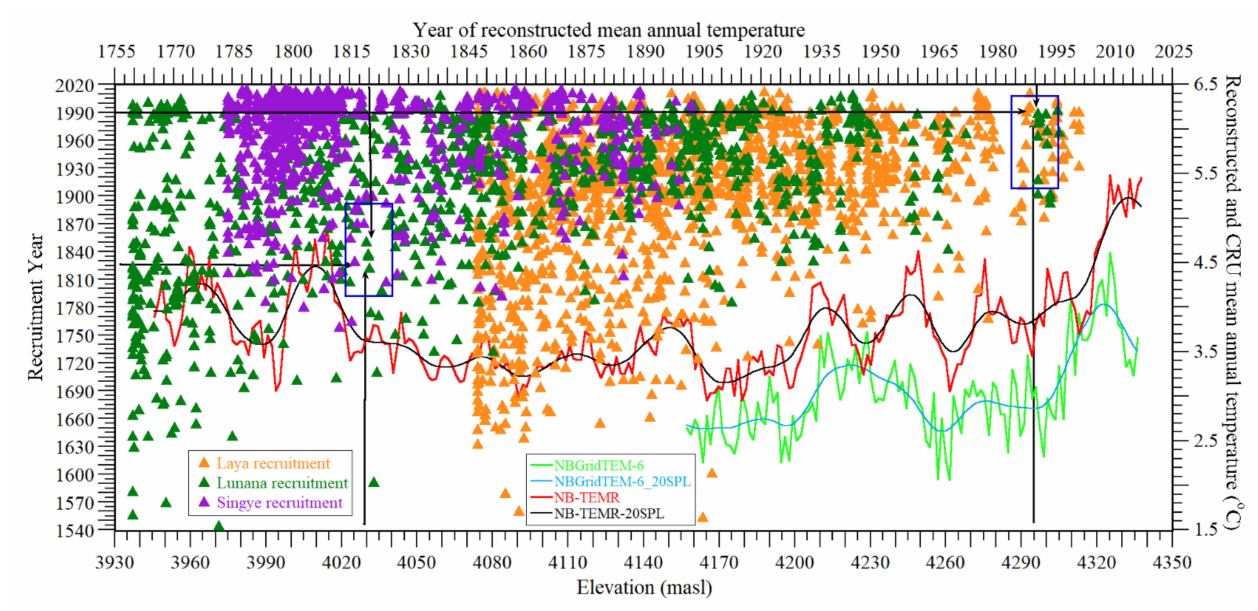
Figure 7. Relationship of tree recruitment frequency distribution with NB-TEMR and NBGridTEM- 6. Mean annual temperature (NB-TEMR—red curve line and NBGridTEM-6—golden curve line) controls tree recruitments in Singye treeline region (purple stake column) and across North Bhutan (green stake column).